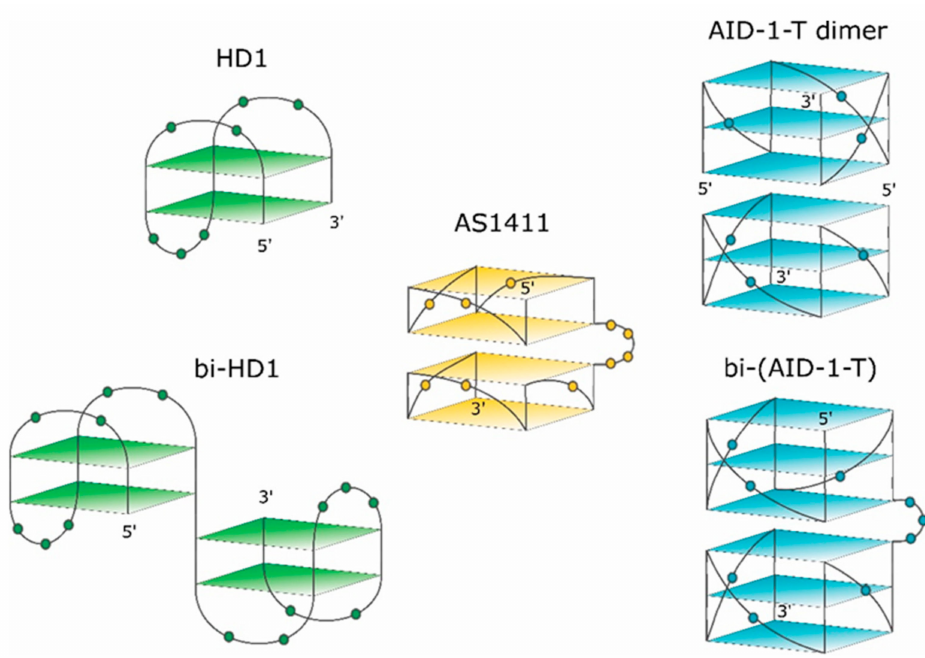
Figure 1. Schematic pictures of putative structures of the GQs under study. The 3-D structure of HD1 is known. 5 (cid:48) - and 3 (cid:48) -ends are indicated. Nucleotides are shown in the loops